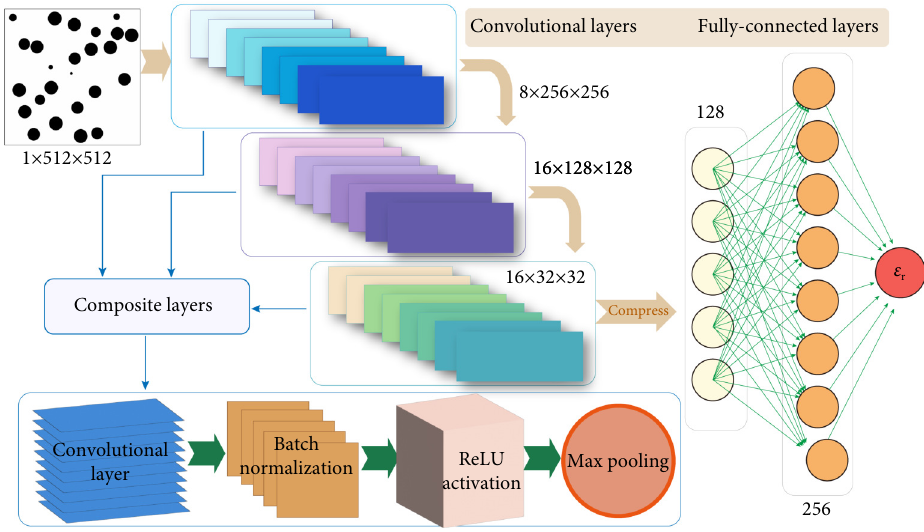
Fig. 4 Illustration of the ConvNet model used in the present study.